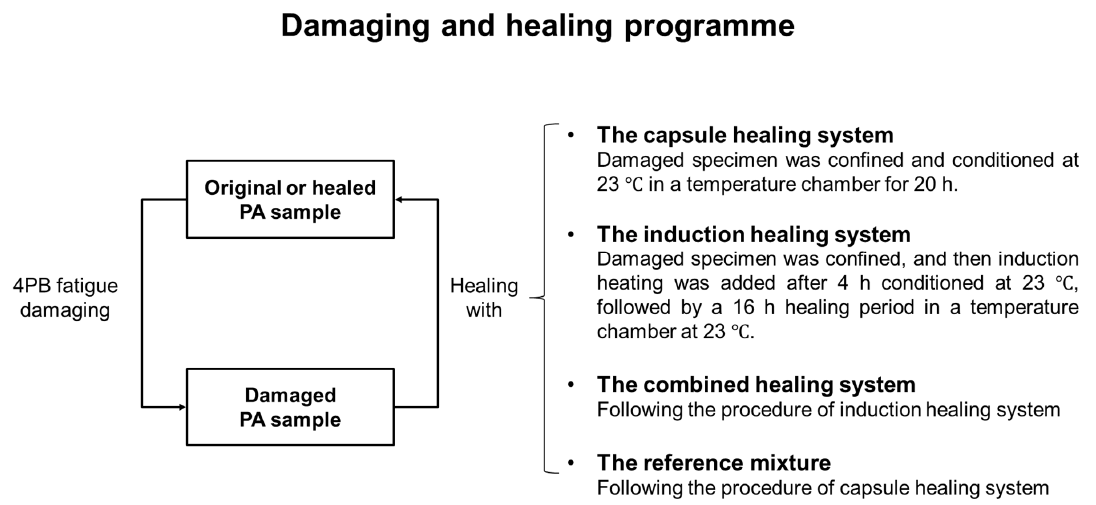
Figure 11. The damaging and healing programme for PA samples with various healing